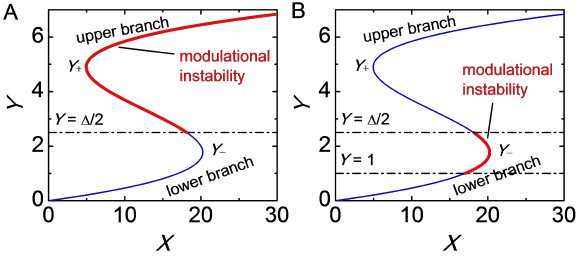
Figure 4: Modulation instability regions on the bistability curve for (A) anomalous dispersion and (B) normal dispersion. The phase detuning is ∆ = 5 . The two inflection points are given by Y ± = [2 ∆ ± (︀ ∆ 2 − 3 )︀ 1/2 ]/3 . The upper and lower branches are stable to cw perturbations while the middle branch between Y ± is cw